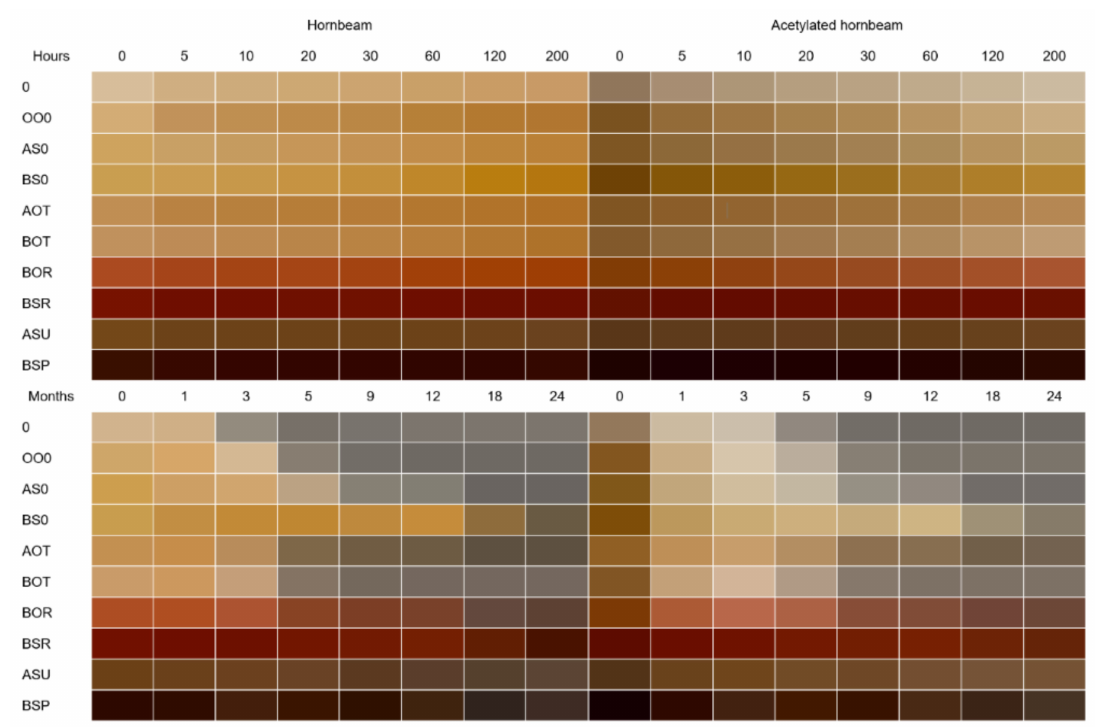
Figure 13. Color chart of uncoated and coated hornbeam and acetylated hornbeam samples